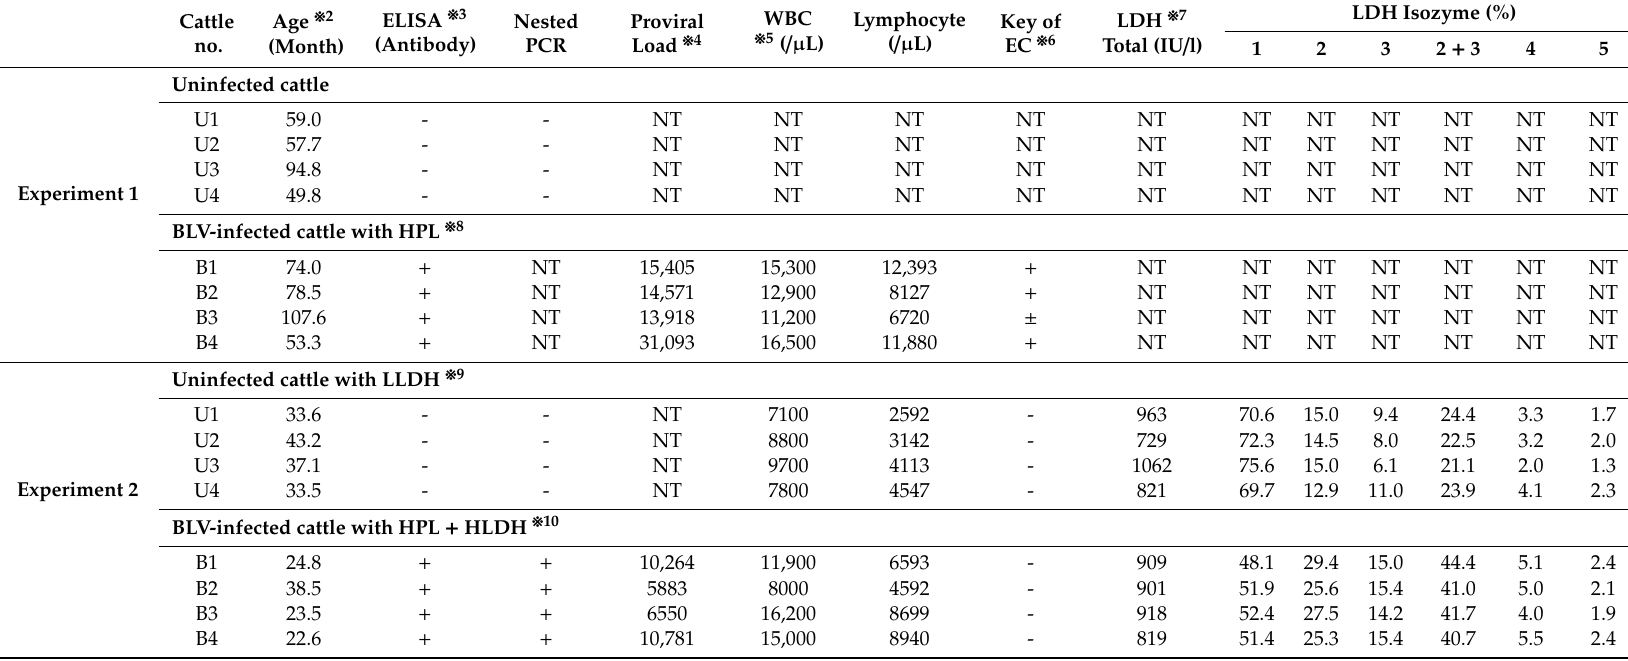
Table 1. Assessment of BLV infection and clinical status of cattle used in this study ※ 1